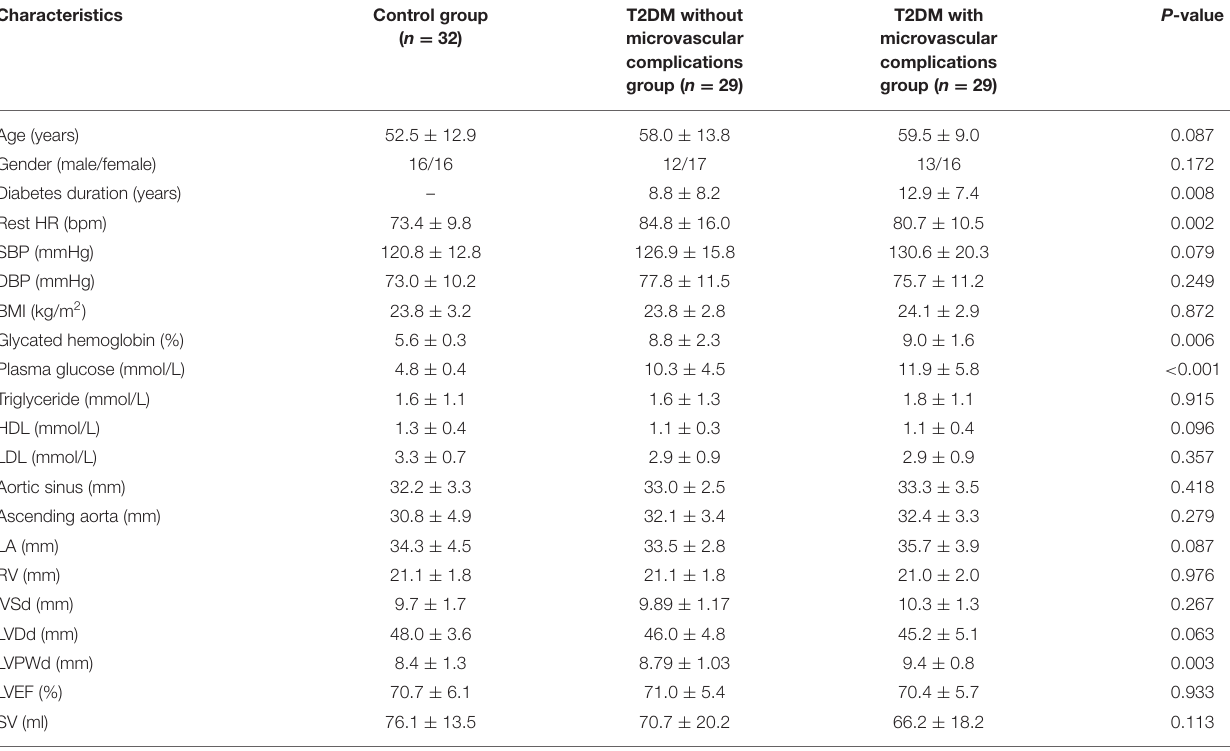
TABLE 1 | Baseline characteristics of the study